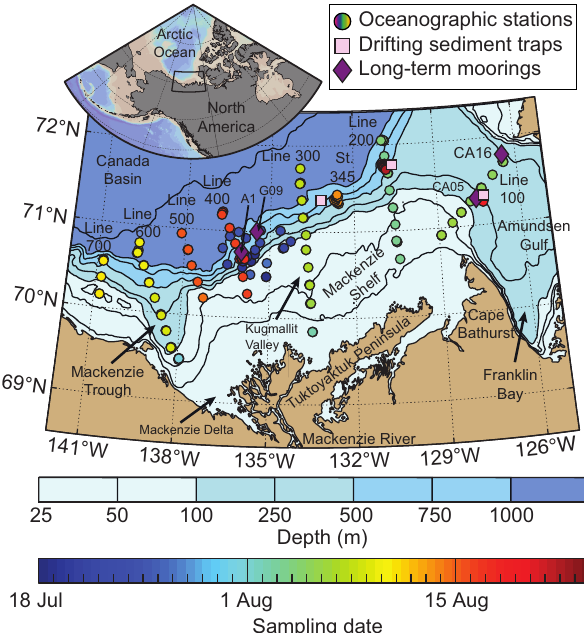
Fig. 1. Bathymetric map of the southeast Beaufort Sea (Arctic Ocean) with position of the sampling stations conducted in July– August 2009 as part of the ArcticNet-Malina campaign. The Arc- ticNet sampling sites were located in the exploration license area EL446, whereas transects 100–700 and station 345 correspond to the Malina sampling grid. On each Malina transect, station IDs are numbered in increasing number from north to south (e.g., 110 to 170 from north to south on line 100). The position of short-term (ca. 24h) and long-term (ca. 1yr) deployments of automated sed- iment traps is also indicated on the map. Technical details on the short-term drifting traps and long-term moorings can be found in Table 1. A 3-D interactive visualization of the bathymetric domain of southeast Beaufort Sea is also accessible through the online Sup- plement (see Appendix C for